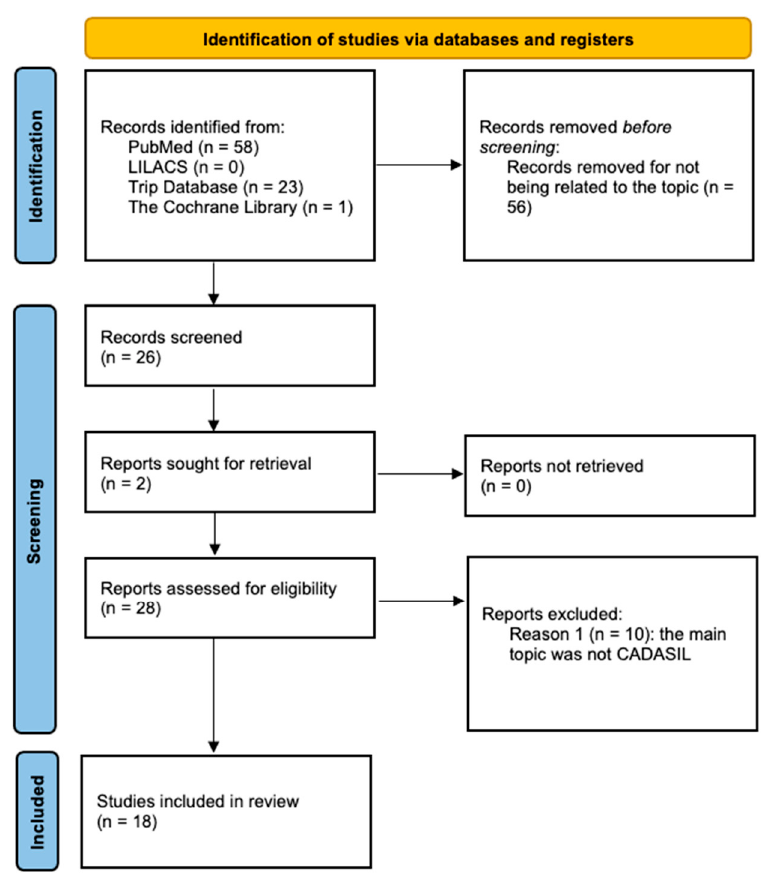
Figure 1. PRISMA flow diagram.